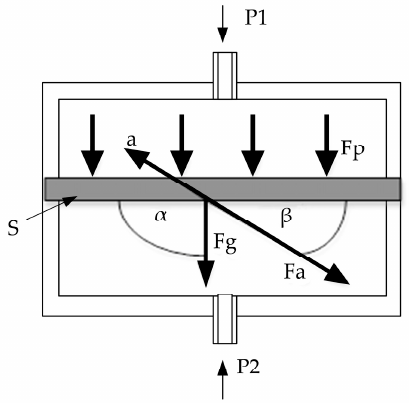
Figure 1. Functional diagram of classic pressure transducer: S—elastic membrane; Fp—pneumatic force; Fa—dynamic acceleration force; β —angle between the membrane and dynamic acceleration force; Fg—membrane weight; α —angle between the membrane and membrane weight; p 1 —pressure applied to the pressure side; p 2 —pressure applied to the vacuum side.